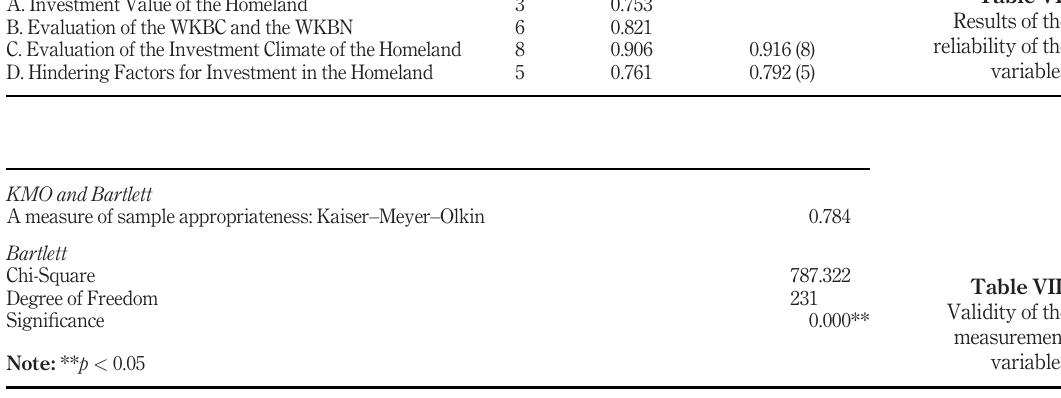
Table VI. Results of the